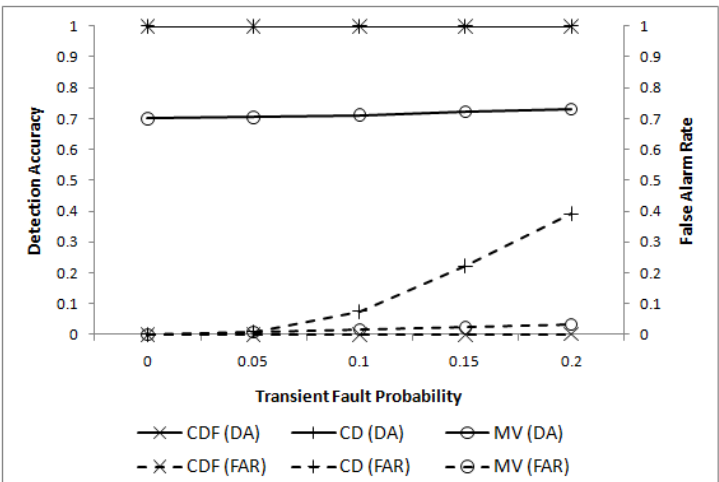
Figure 3. Improving DA and FAR using a smoothing filter.